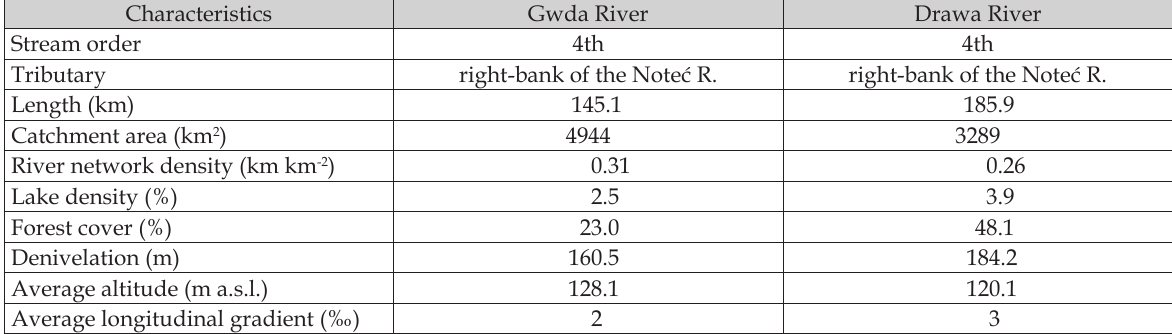
Table 1. Characteristics of the Gwda and Drawa rivers and their catchments (RzGW 2013)